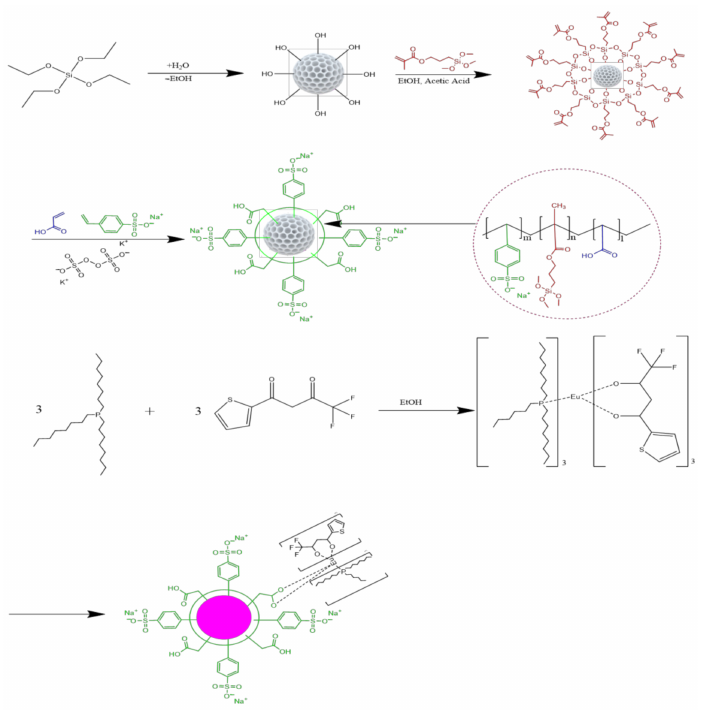
Figure 1. Schematic flow diagram of the synthesis route for Eu(TTA) 3 (P(Oct) 3 ) 3 modified MSP by multi-step process. First, both surface and nanocavities of mesoporous silica particles (MSP) were modified with a silane coupling agent, i.e., 3-(trimethoxysilyl)propyl methacrylate (TMSPMA) as an intermediary to activate of acryloyl group. To activate the carboxylic acid, MMA, sodium styrene sulfonate (SSS), and potassium persulfate (PPS) as a catalysis are added and temperature was increased to 70 ◦ C. β -diketone europium complex, Eu(TTA) 3 (P(Oct) 3 ) 3, was prepared by mixing the stoichiometric compositions of Eu 3+ , TTA and P(Oct) 3 in EtOH. Eu(TTA) 3 (P(Oct) 3 ) 3 @MSP (Eu@MSP) were synthesized by dropwise addition of Eu(TTA) 3 (P(Oct) 3 ) 3 carboxylic acid activated